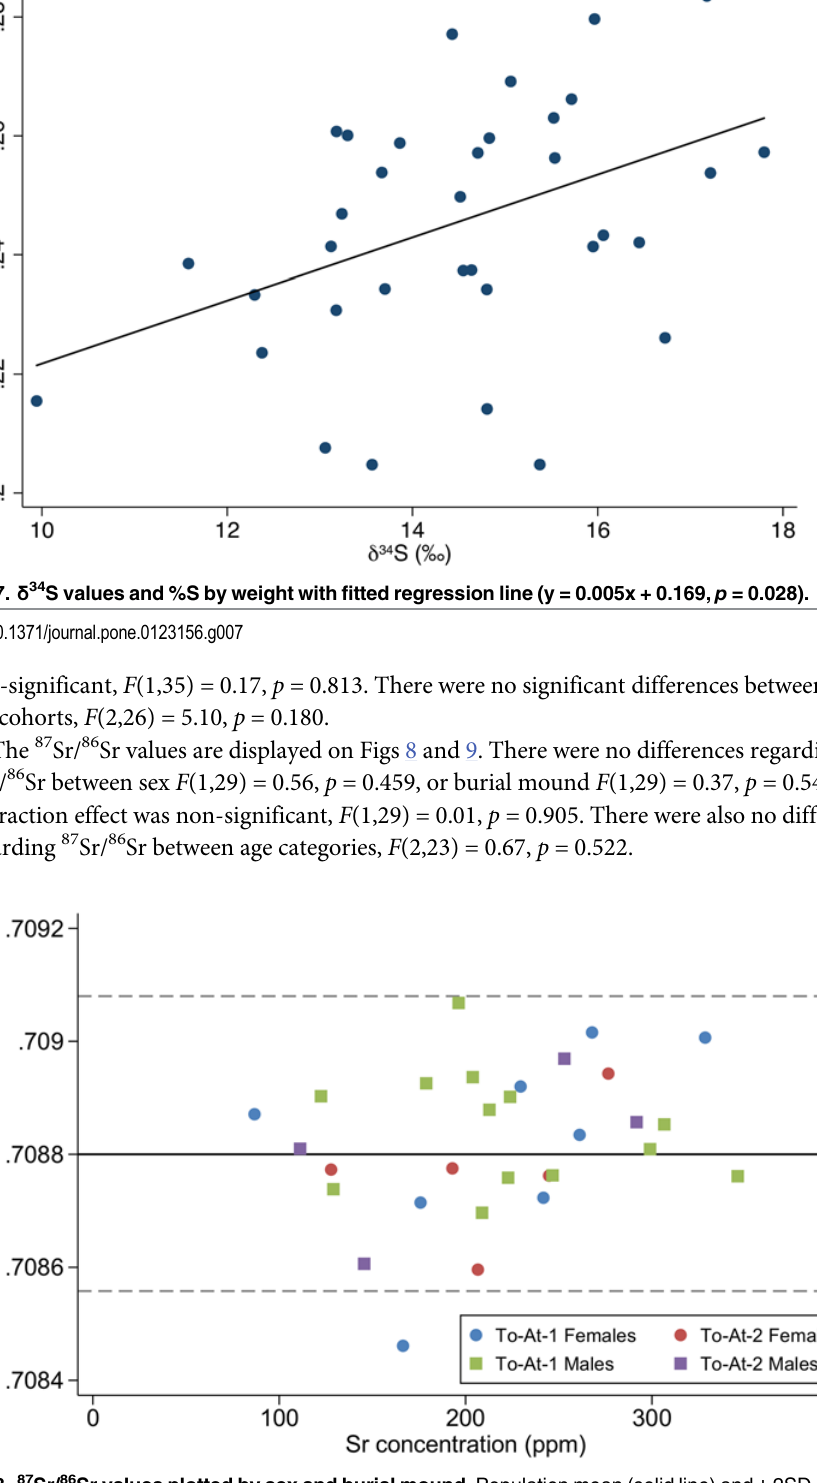
Fig 8. 87 Sr/ 86 Sr values plotted by sex and burial mound. Population mean (solid line) and ± 2SD (dashed line) represented.